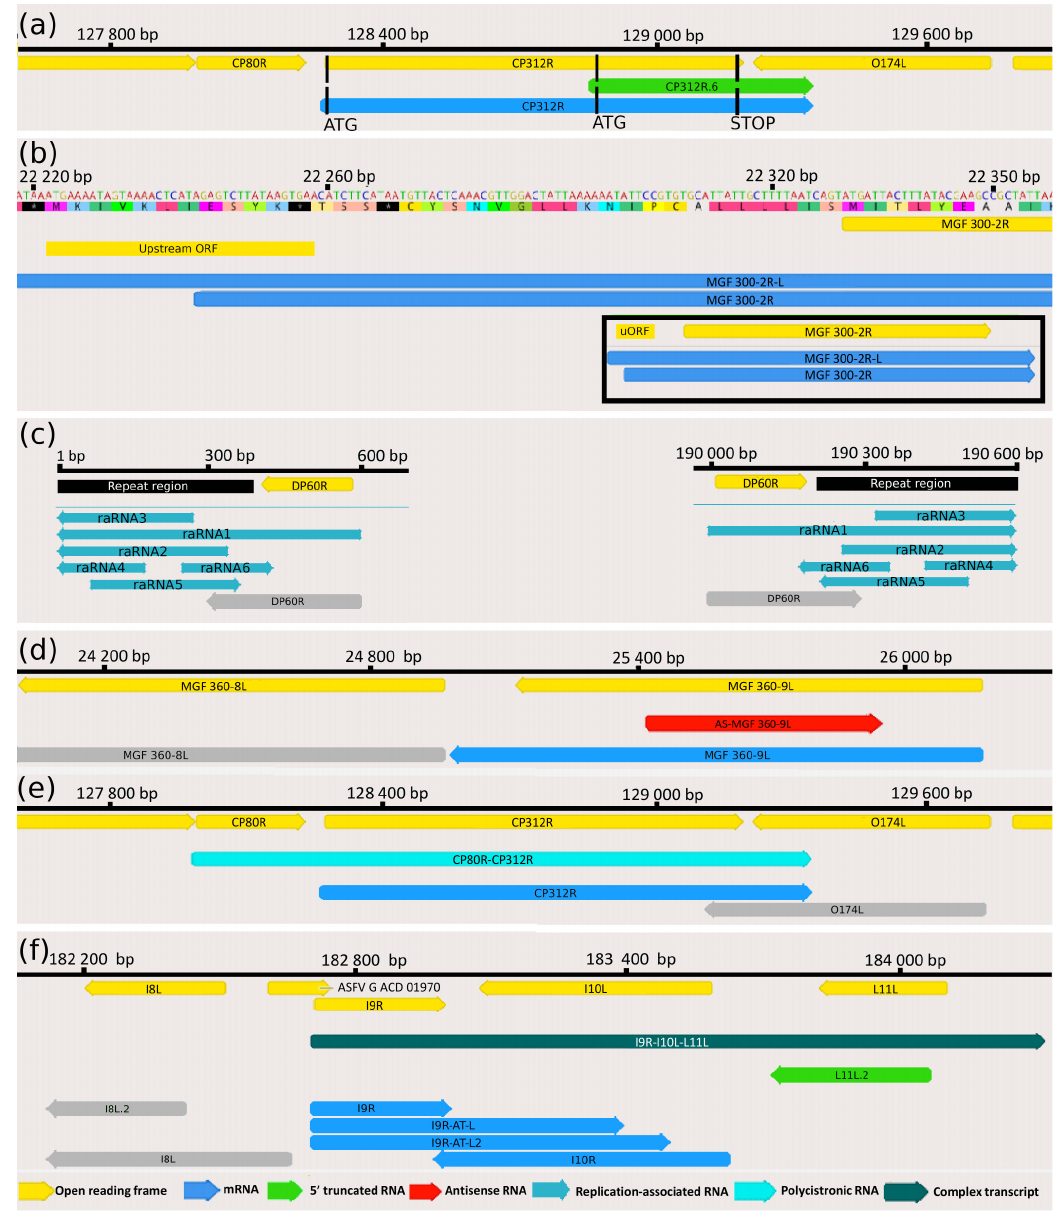
Figure 4. Examples for the ASFV transcript classes ( a ) 5 ′ -truncated mRNAs. This part of the figure illustrates the putative nested mRNAs (CP312R.6; green arrow, embedded into the larger CP312R transcript; blue arrow) containing short 5 ′ - truncated in-frame ORFs within the canonical ORFs (CP312R gene; yellow arrow). ( b ) Transcripts containing upstream ORFs MGF 300-2R transcript and its longer 5 ′ -UTR isoform (MGF 300-2R-L) containing an uORF (yellow rectangle) is illustrated in this picture. The bracketed picture contains two full-length transcript isoforms (blue arrows), as well as the ORF of the gene encoding them and the uORF (yellow arrows). ( c ) Replication origin-associated RNAs This figure illustrates the repeat region at the genomic termini (black rectangle) and the raRNAs (turquoise arrows), which overlap or situated at the vicinity of the Oris, of which the precise location is unknown. ( d ) Antisense RNAs The red arrow indicates an asRNA (AS-MGF 360-9L) overlapping the MGF 360-9L gene (blue arrow) in opposite polarity. ( e ) Polycistronic RNAs CP80R-CP312R bicistronic transcript (light green arrow) comprising two tandemly oriented genes, of which the CP312R is also expressed as a monocistronic RNA molecule (blue arrow). ( f ) Complex transcripts The I9R-I10L-L11L complex transcript (dark green) comprises three genes, of which I9R (encoding three TSS isoforms; blue arrows) stands in an opposite orientation compared to the other two genes (L11L.2 and I10L).